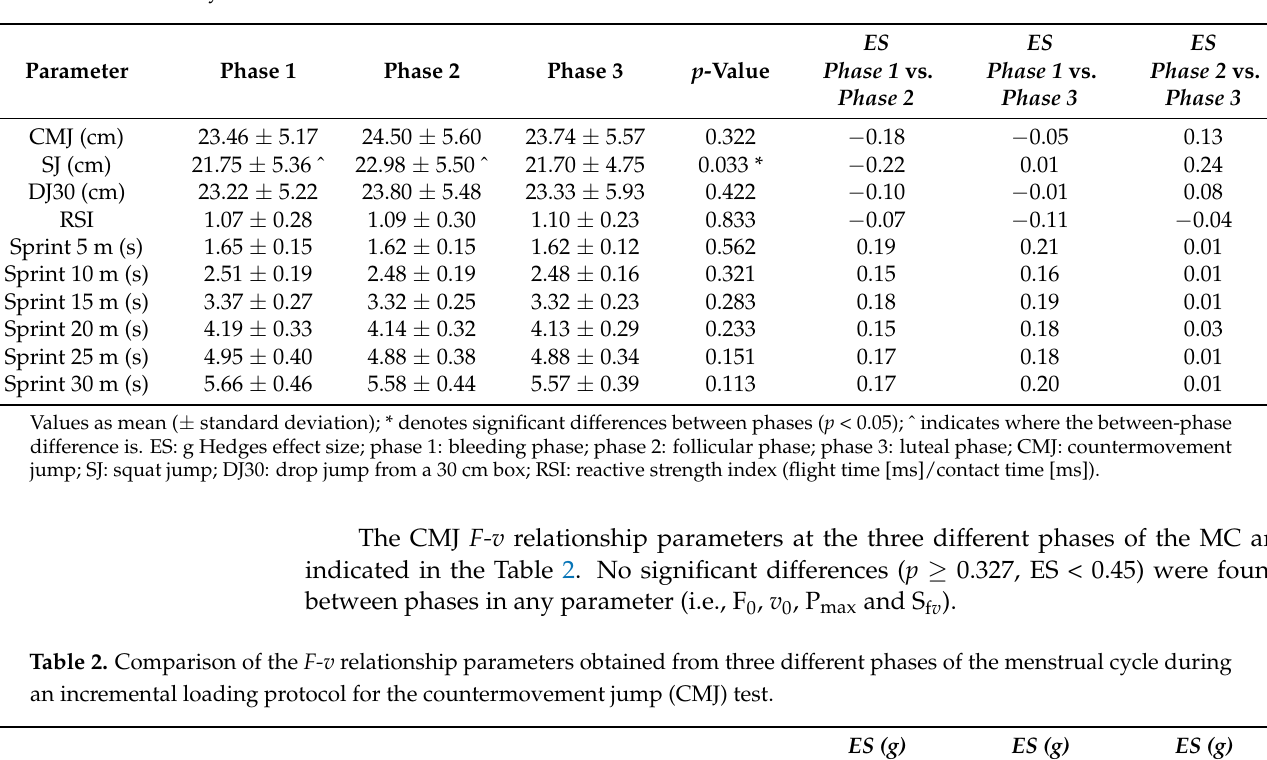
Table 1. Comparison of the vertical jumping and 30 m sprint performance parameters obtained from three different phases of the menstrual cycle.